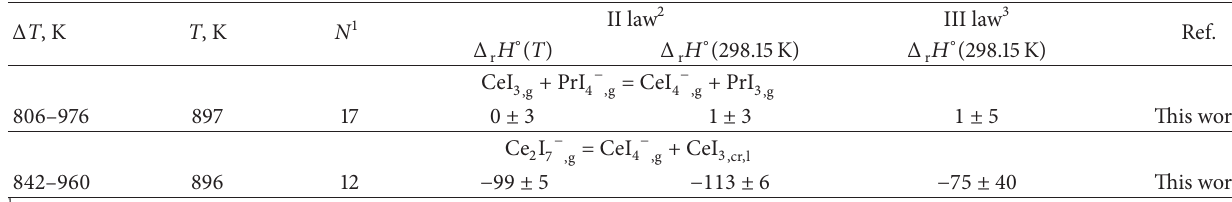
Table 6: Enthalpies (kJ ⋅ mol −1 ) of reactions (3) and (4).